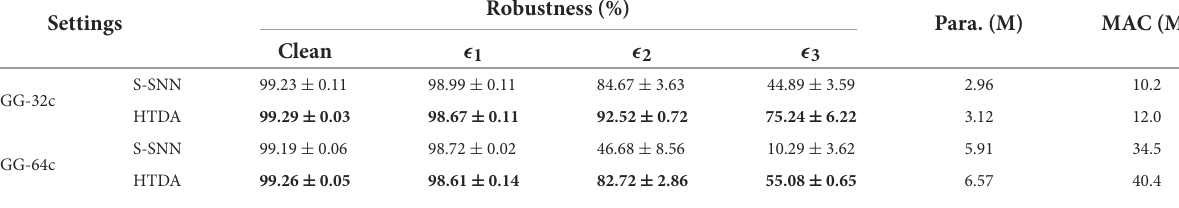
TABLE 3 Comparison of different models on N-MNIST.